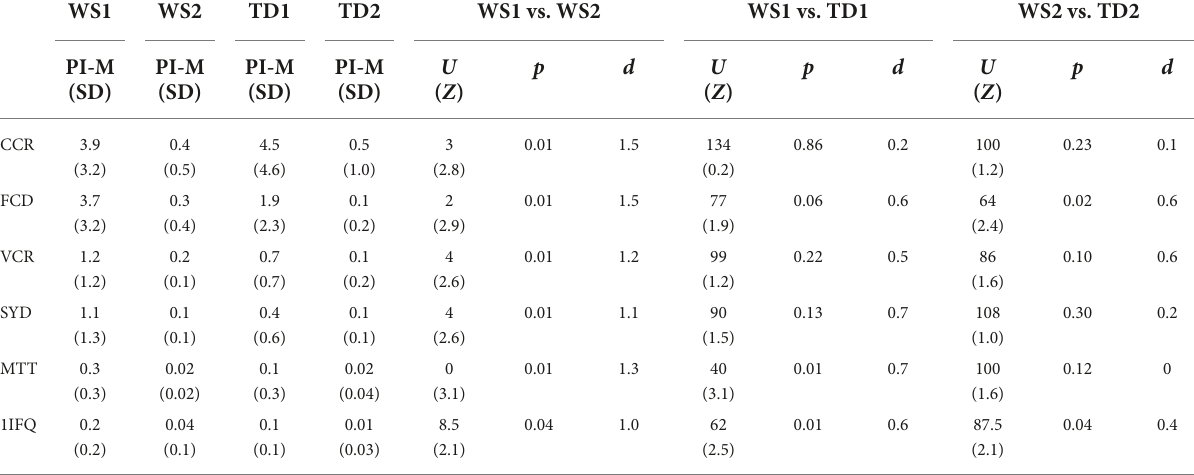
TABLE 3 Syllable structure phonological processes index means and standard deviations for groups, Mann–Whitney U test, and effect size.